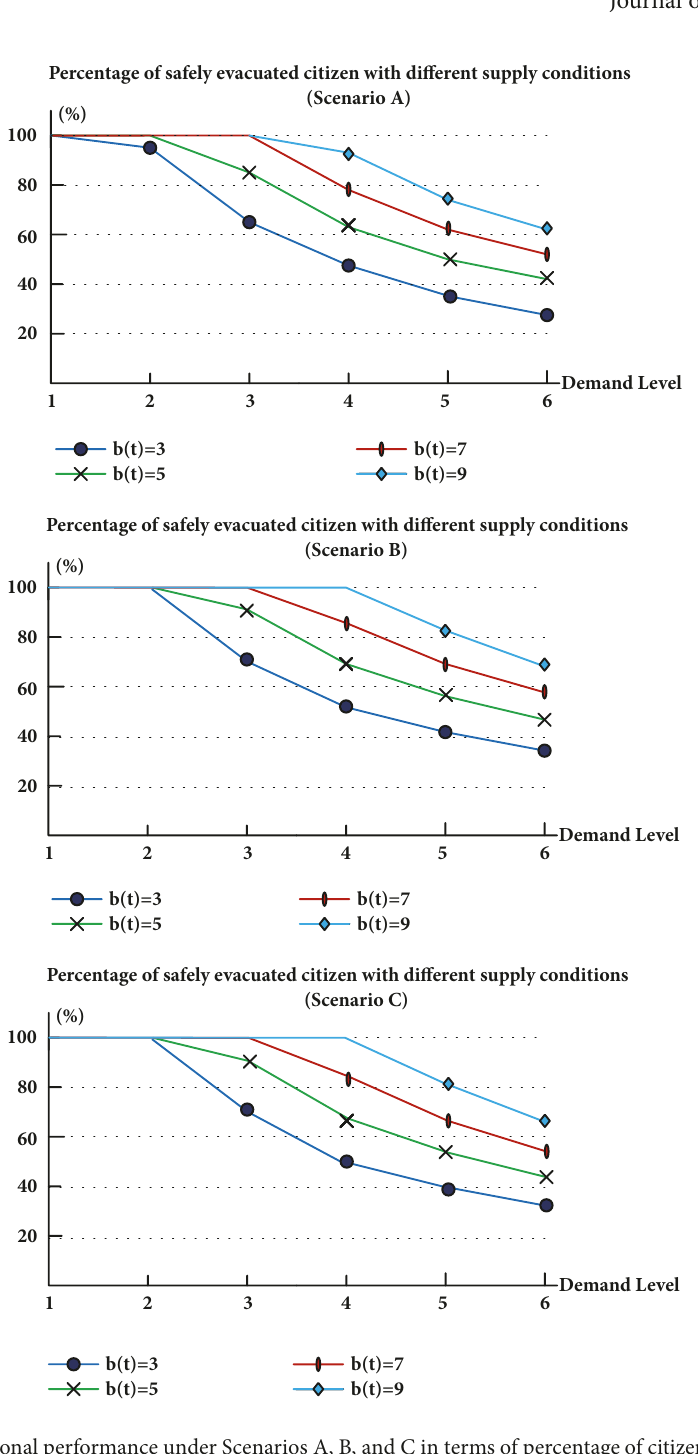
Figure 4: Operational performance under Scenarios A, B, and C in terms of percentage of citizens saved by